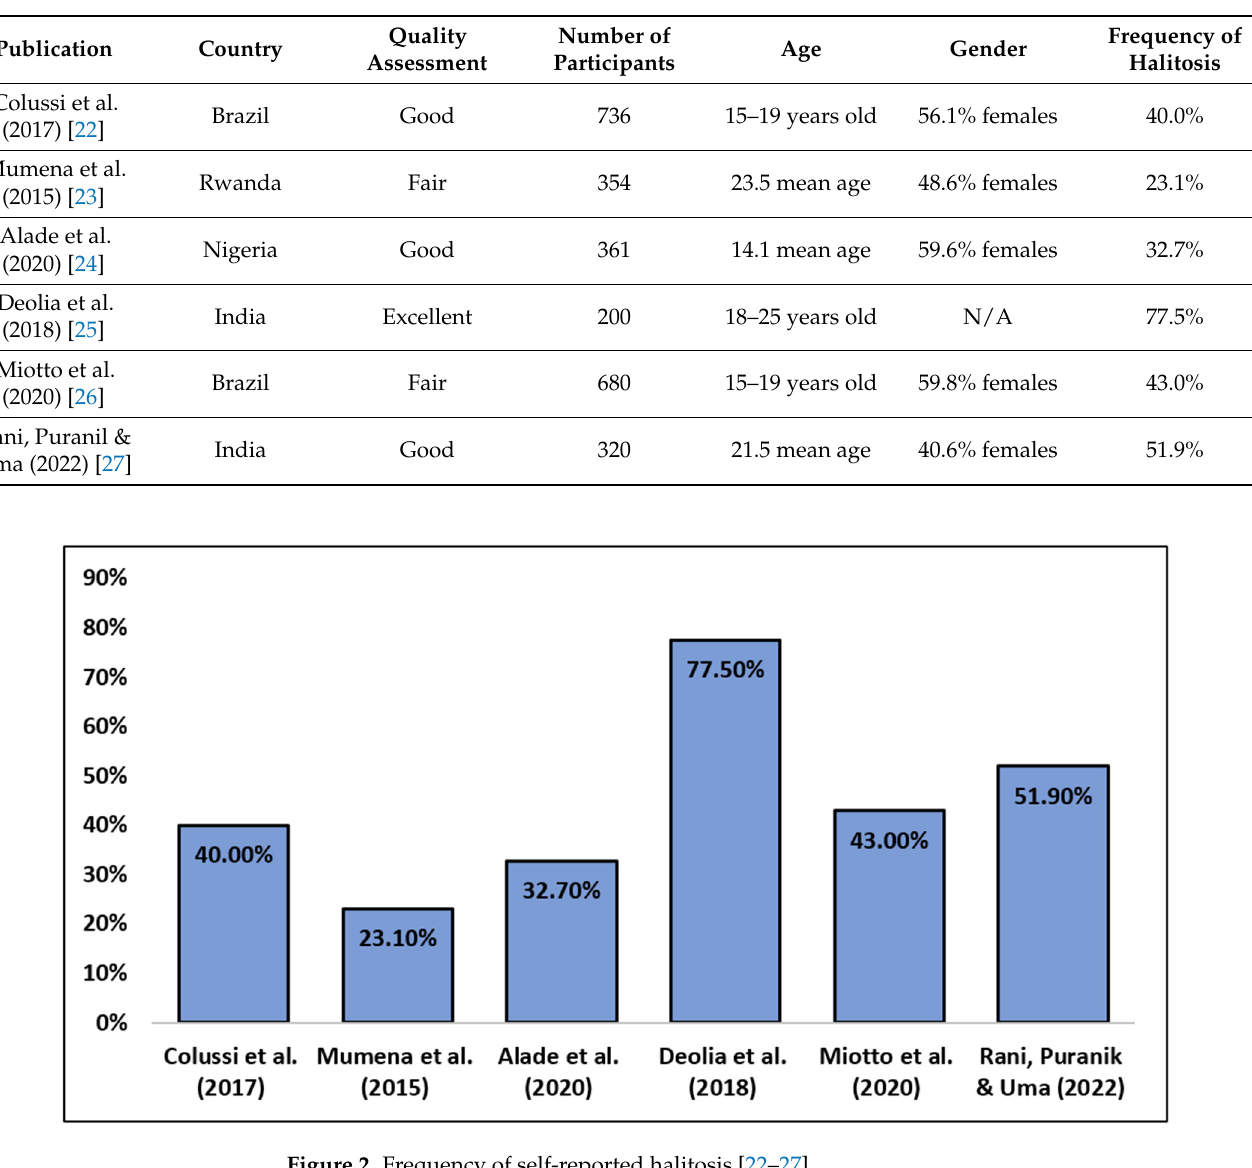
Figure 2 . Frequency of self-reported halitosis [22–27]